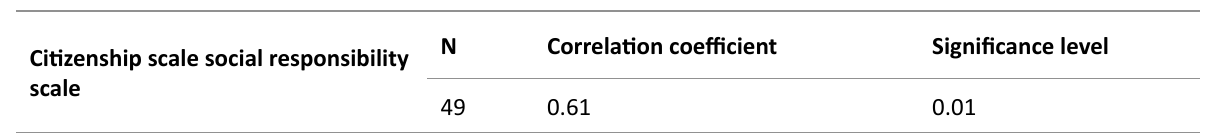
Table 3. Shows the Pearson correlation coefficient between the scales of citizenship and social responsibility among physical education